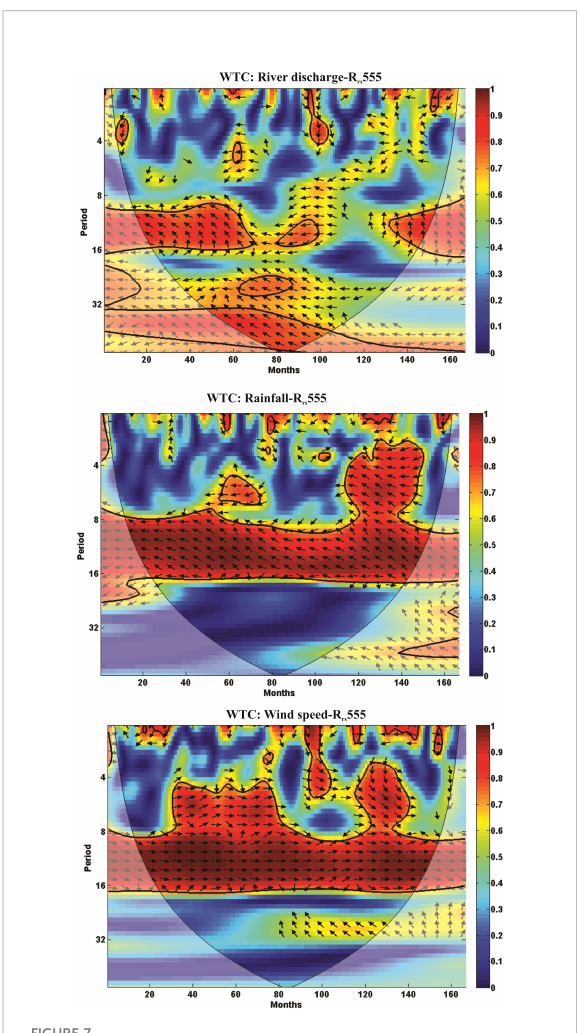
FIGURE 7 Wavelet transform coherence between environmental variables and R rs 555: river discharge – R rs 555 (upper panel), Rainfall – R rs 555 (middle panel), and wind speed – R rs 555 (lower panel). The regions with signi fi cant edge in fl uence are shaded. The arrows indicate the phase difference between the time series. When the two time series are in phase (0°), the arrows point to the right; when two time series are out of phase (180°), the arrows point to the left. The color bar indicates the variation of correlation coef fi cient.